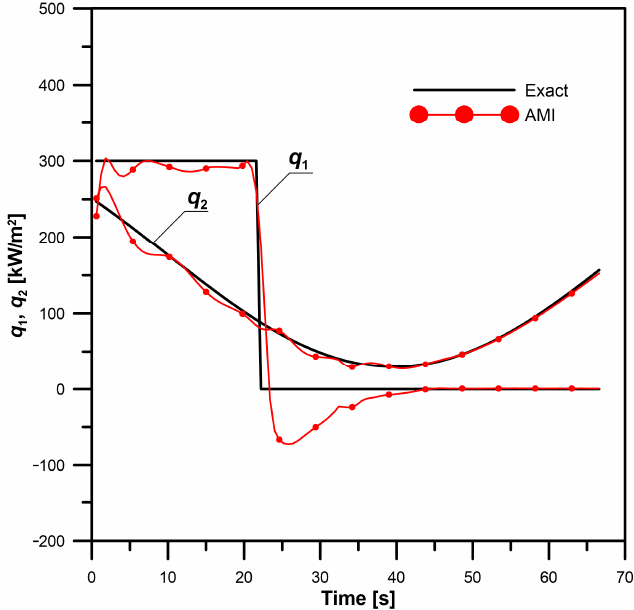
Figure 13. Comparison between exact heat fluxes and those calculated by the AMI method from the system restart.